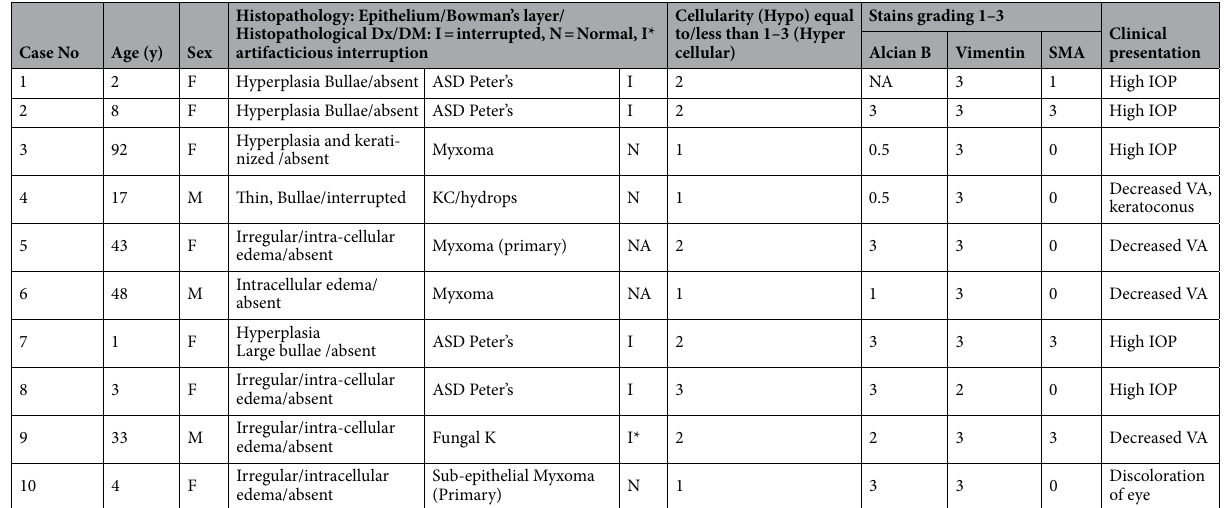
Table 3. The histopathological and immunohistochemical results of the corneas with clinical